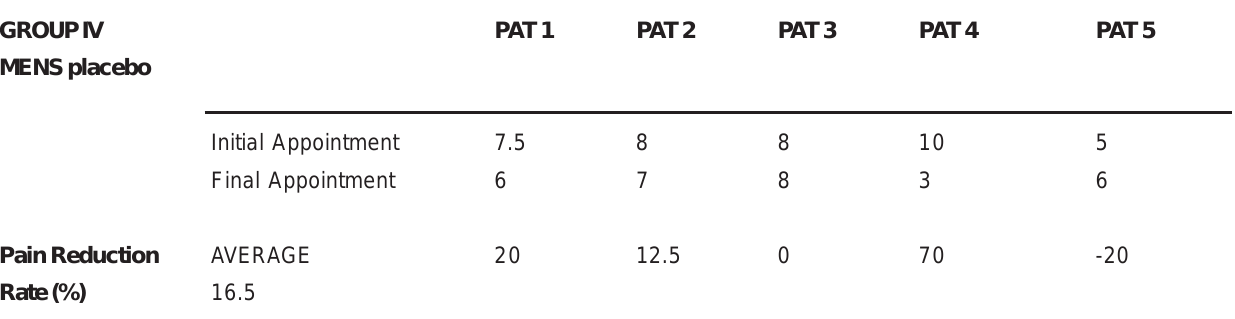
TABLE 4- Pain level of patients before and after treatment in group IV (MENS placebo) using a Visual Analogue GROUP IV PAT 1 MENS placebo